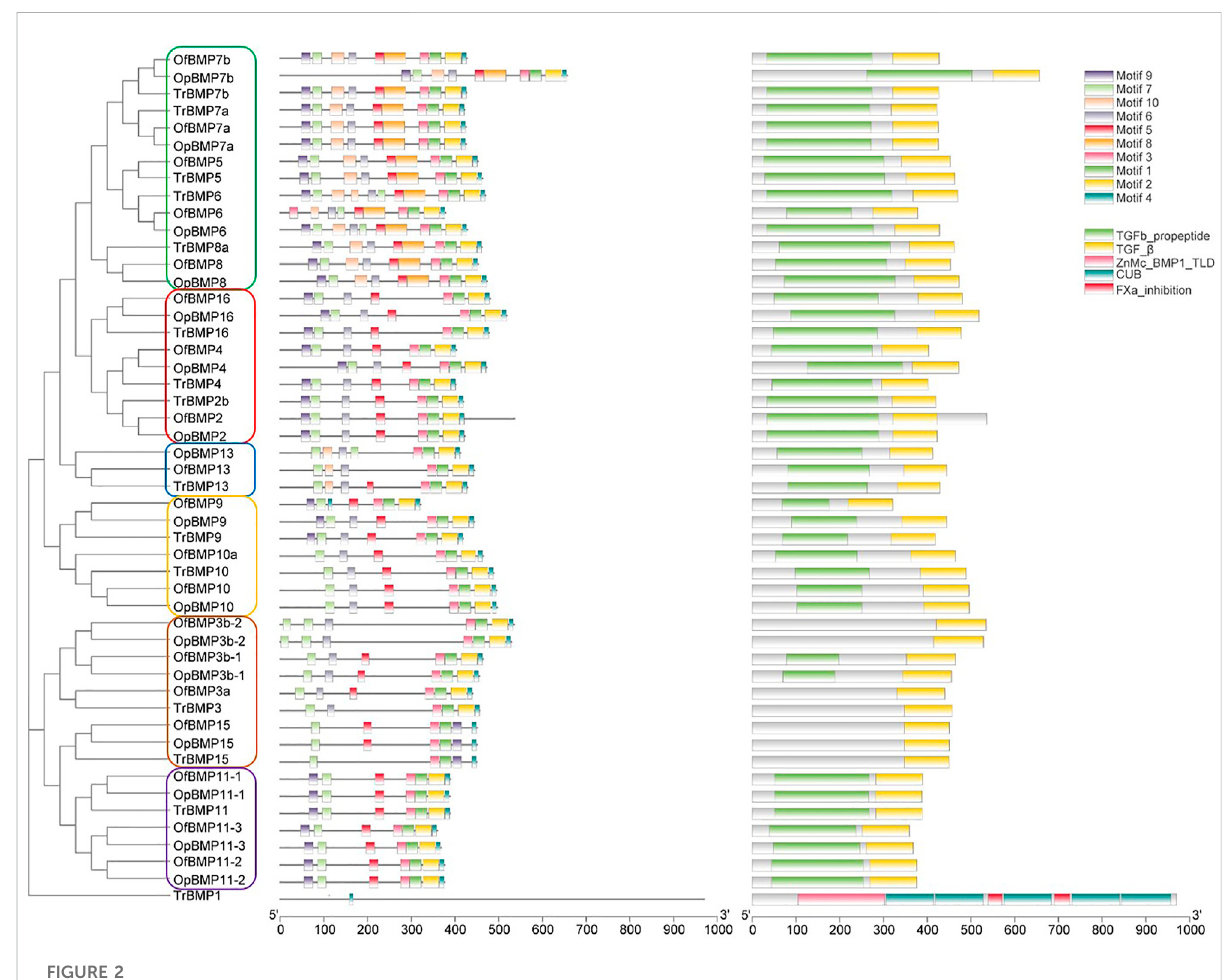
FIGURE 2 The conserved BMP domains and motifs in Oplegnathus and T. rubripes